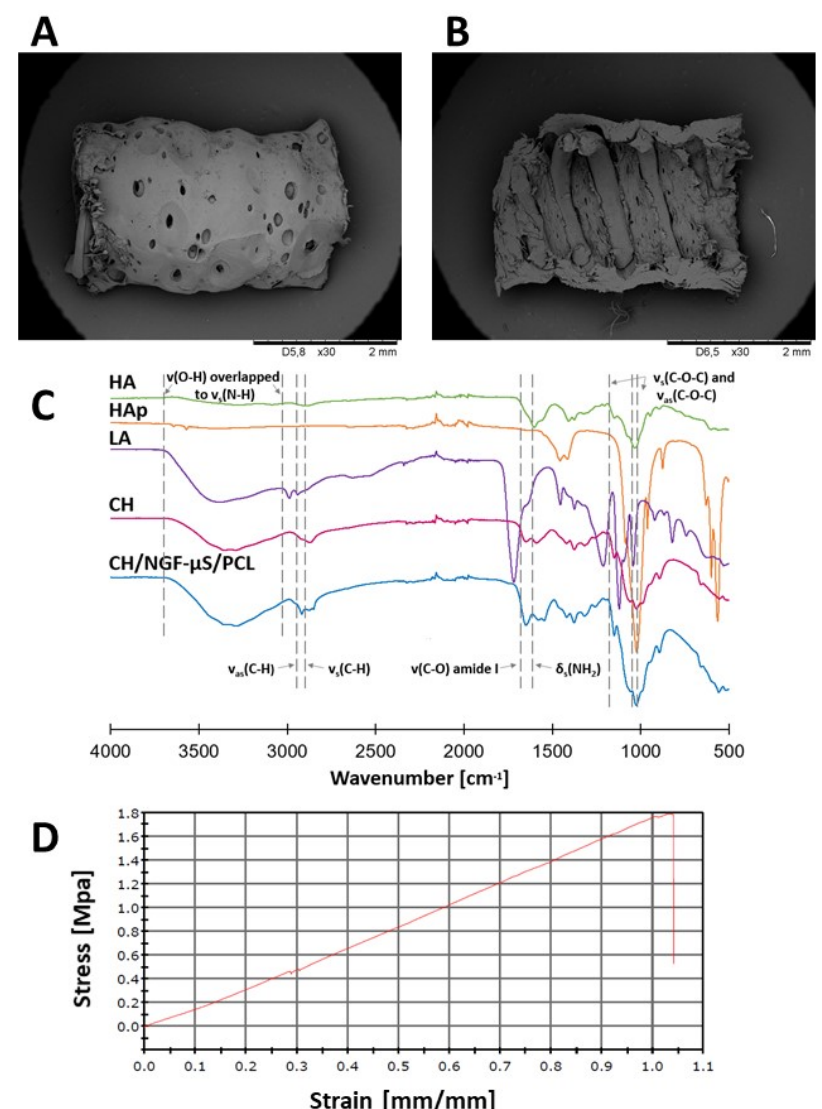
Figure 5. SEM images at 30 × magnification of ( A ) longitudinal view and ( B ) inner sidewall view of CH/NGF- µ S/PCL conduit. ( C ) FTIR spectrum of outer side of external surface of CH/NGF- µ S/PCL conduit. ( D ) Example of stress–strain profile.